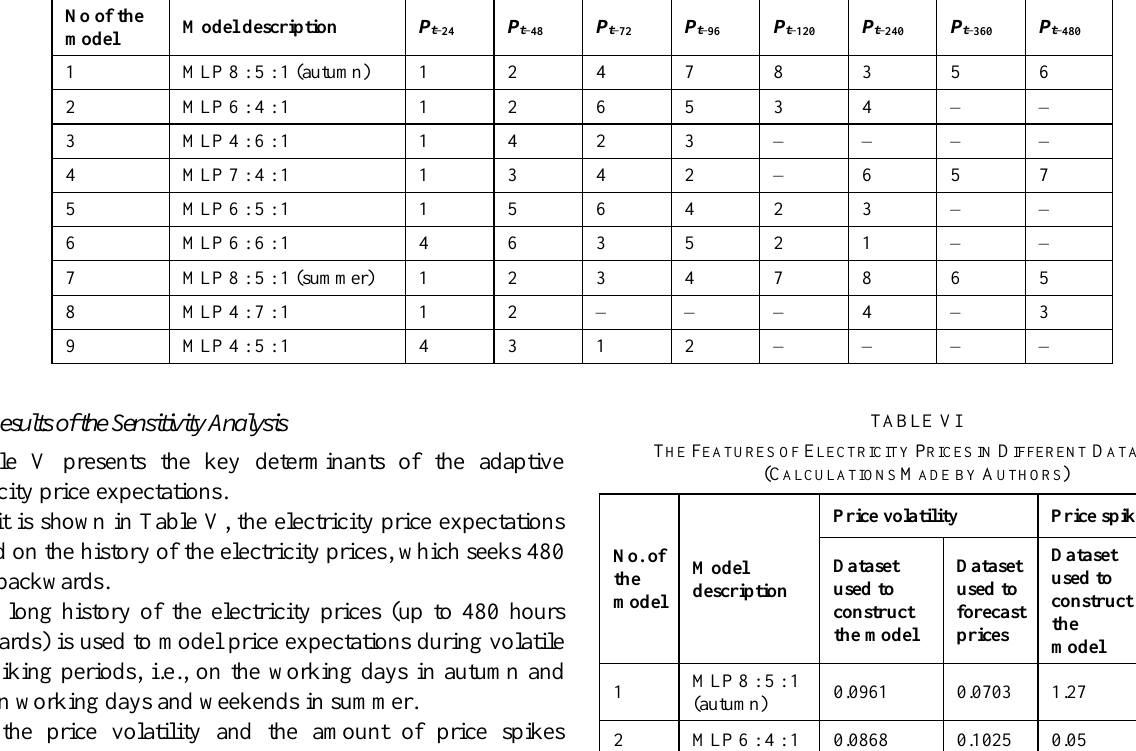
Dataset used to forecast prices